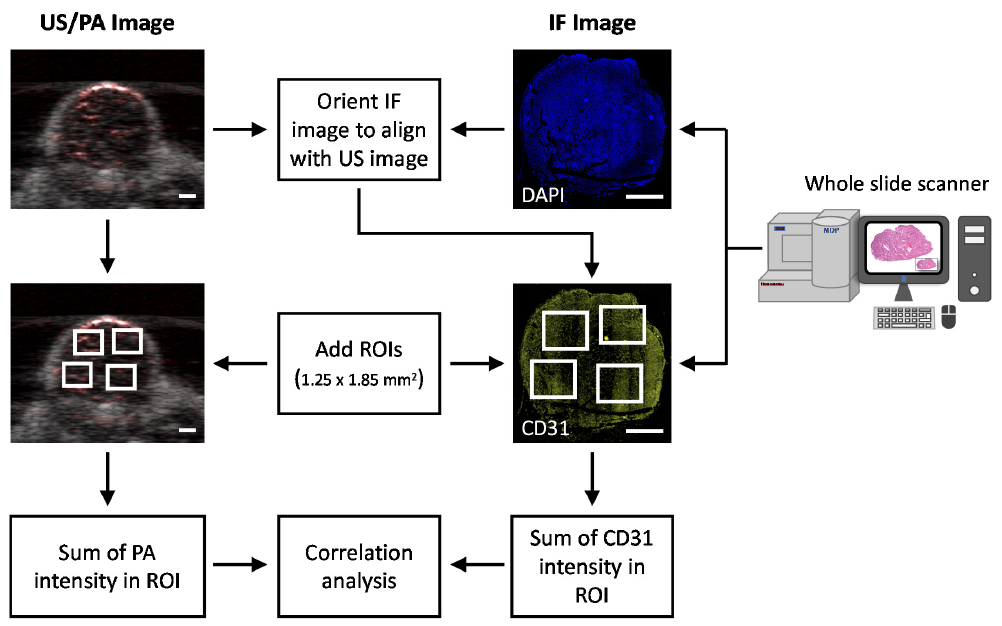
Figure 2. Flowchart describing the image processing methodology to correlate CD31 signal intensity with PA signals. (Scale bar = 2 mm).